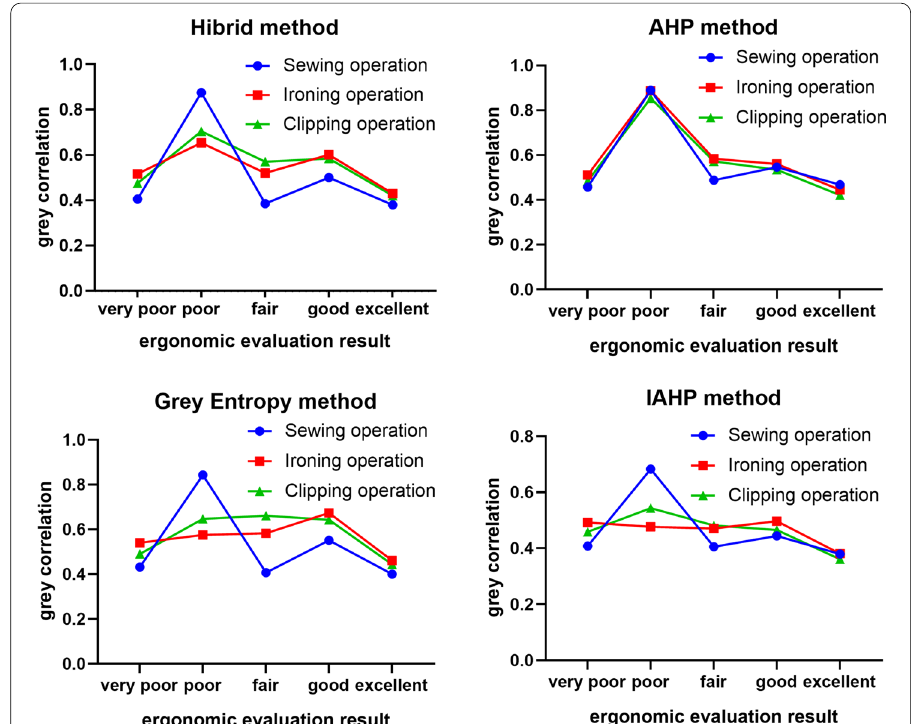
Fig. 6 Comparison of evaluation result for the four